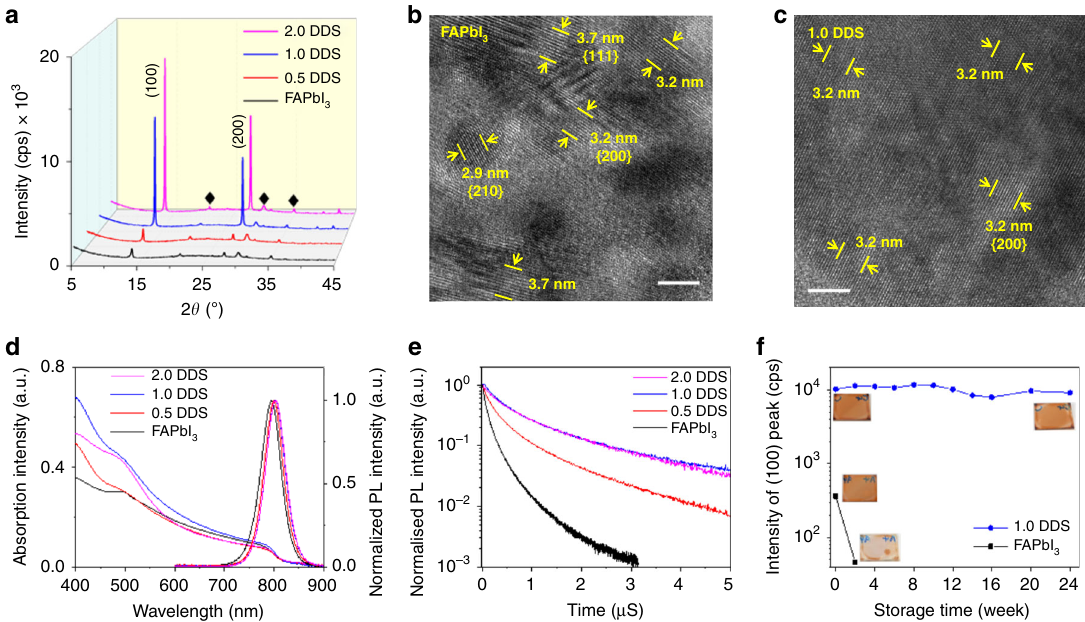
Fig. 2 Properties of PMC thin fi lms. a XRD patterns of perovskite fi lms; diffraction peaks from the ITO substrate are marked as ♦ . Cross-sectional HRTEM images of ( b ) the FAPbI 3 control fi lm and ( c ) the 1.0 DDS fi lm. The measured lattice spacings (10 fringes for each pair of markers) match well with the cubic α -phase FAPbI 3 structure. The scale bars for ( b ) and ( c ) are 5 nm. d Absorption and PL spectra and e time-correlated single-photon counting spectra (recorded at a fl uence of 0.13 μ J cm − 2 ) of perovskite fi lms. f XRD intensity of the (100) diffraction peak of perovskite fi lms (inset: photographs of the fresh and aged perovskite fi